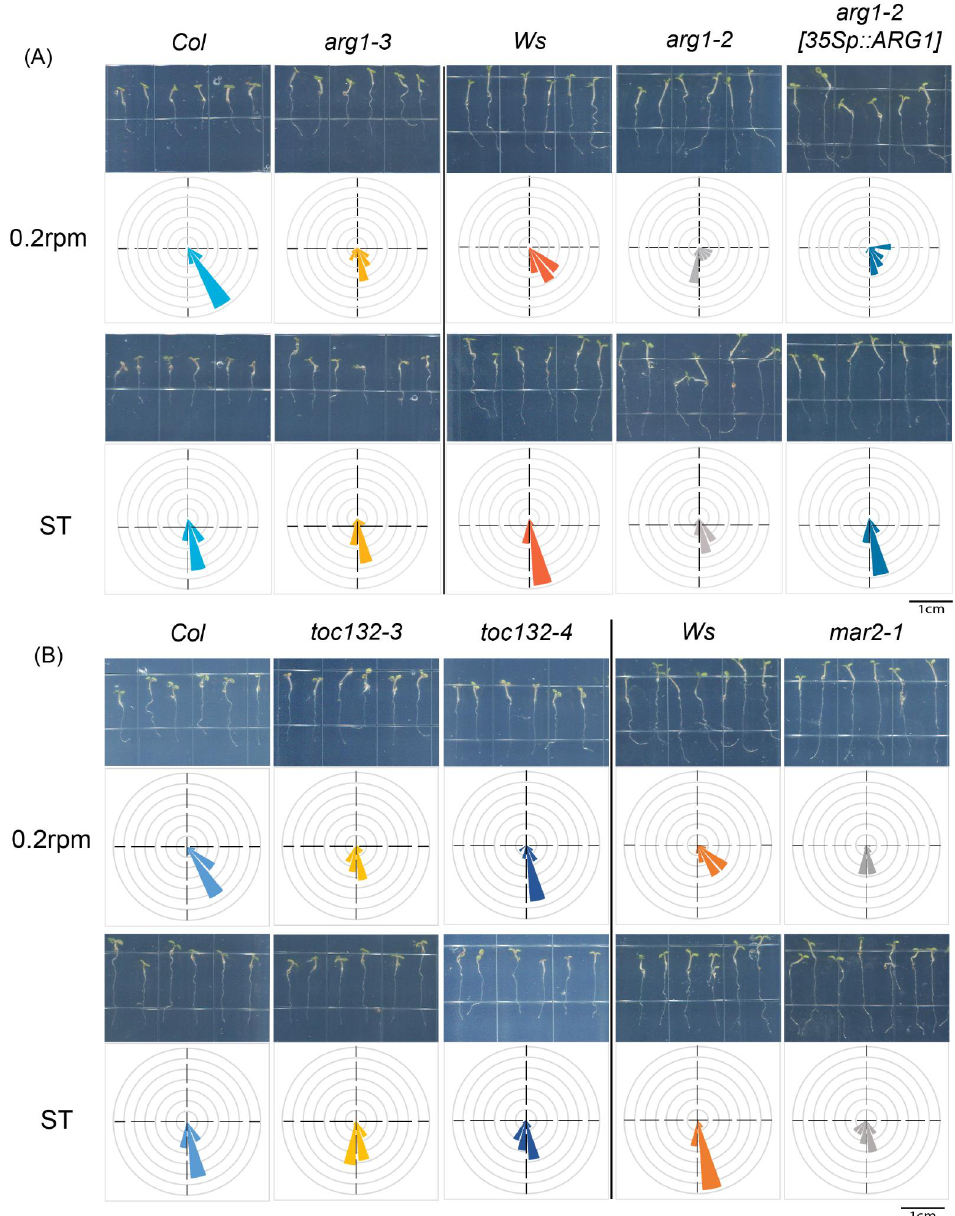
Figure 2. Gravitropism-deficient Arabidopsis mutants do not show root tip curvature responses to low- speed clinorotation: 5-day-old wild type, mutant, and transgenically rescued Arabidopsis seedlings were subjected to either 0.2 RPM vertical clinorotation or stationary growth (ST) in darkness for 18 h. Rose plots of root tip angles measured at the end of each experiment are represented for each genotype (represented at the top) and each experimental condition (represented on the left). These rose plots are split into 18 bins of 20 degrees each. The proportion of the measured population of root tip angles falling into a specific bin is represented by a wedge within that bin. The bin representing seedlings with root tips directed toward the bottom within 0 to 20 degrees of the vertical is directed to the bottom, the bin representing 80–100 degrees is directed to the right, the one representing 160–180 degrees to the top, and the one representing 260–280 degrees to the left. Photographs of representative seedlings taken at the end of each experiment are shown above each rose plot. Several alleles of ( A ) arg1 and ( B ) toc132 were tested in this experiment, along with their respective wild types, and an arg1-2 mutant line transformed with a 35Sp::ARG1 transgene ( arg1-2[35S:ARG1] ). n N =